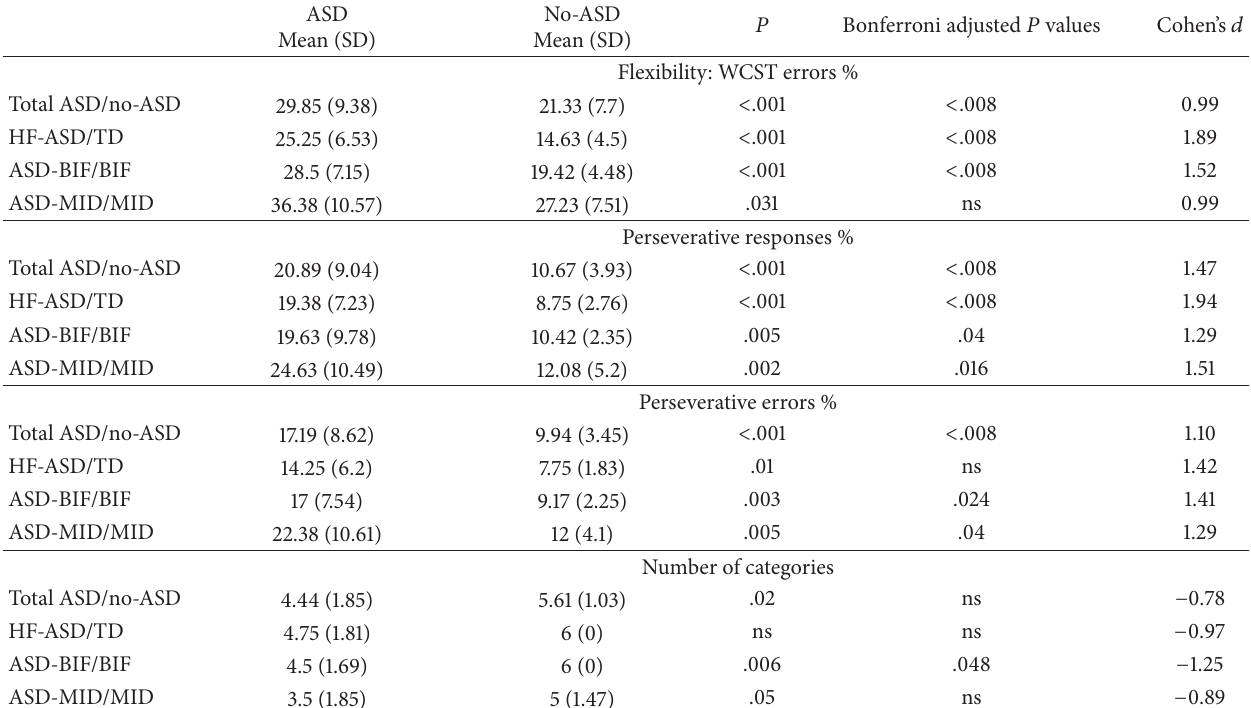
Table 3: Means, SD, and statistically significant differences ( 𝑡 test; Bonferroni correction: 𝑃 ≤ .00625 ; Cohen’s test) obtained from ASD and no-ASD groups at WCST.